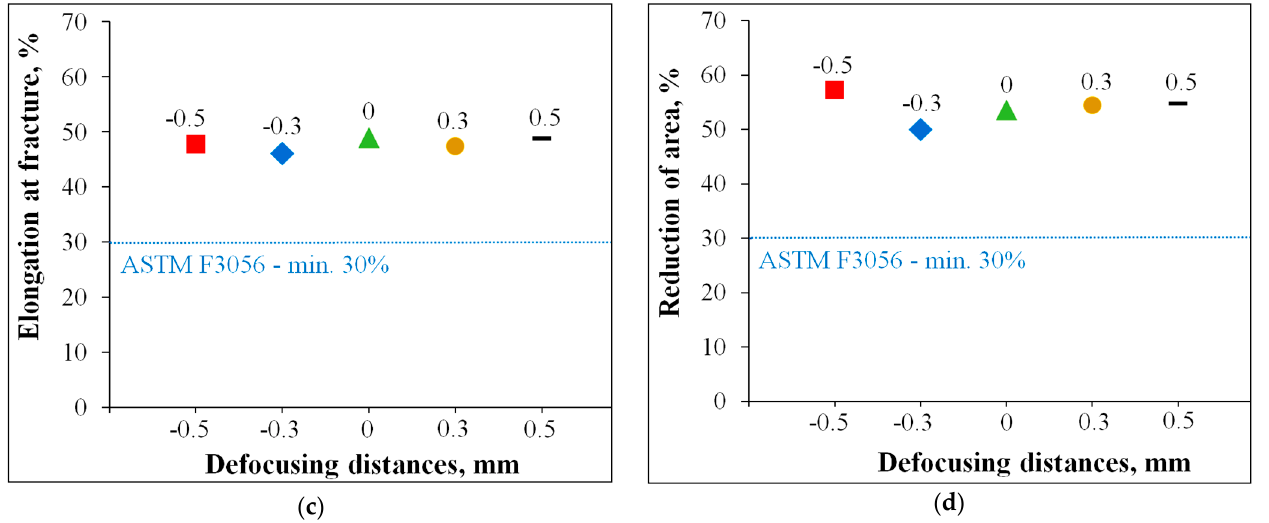
Figure 8. Tensile properties of specimens built with different defocusing distances: ( a ) UTS; ( b ) YS; ( c ) El; ( d ) RA